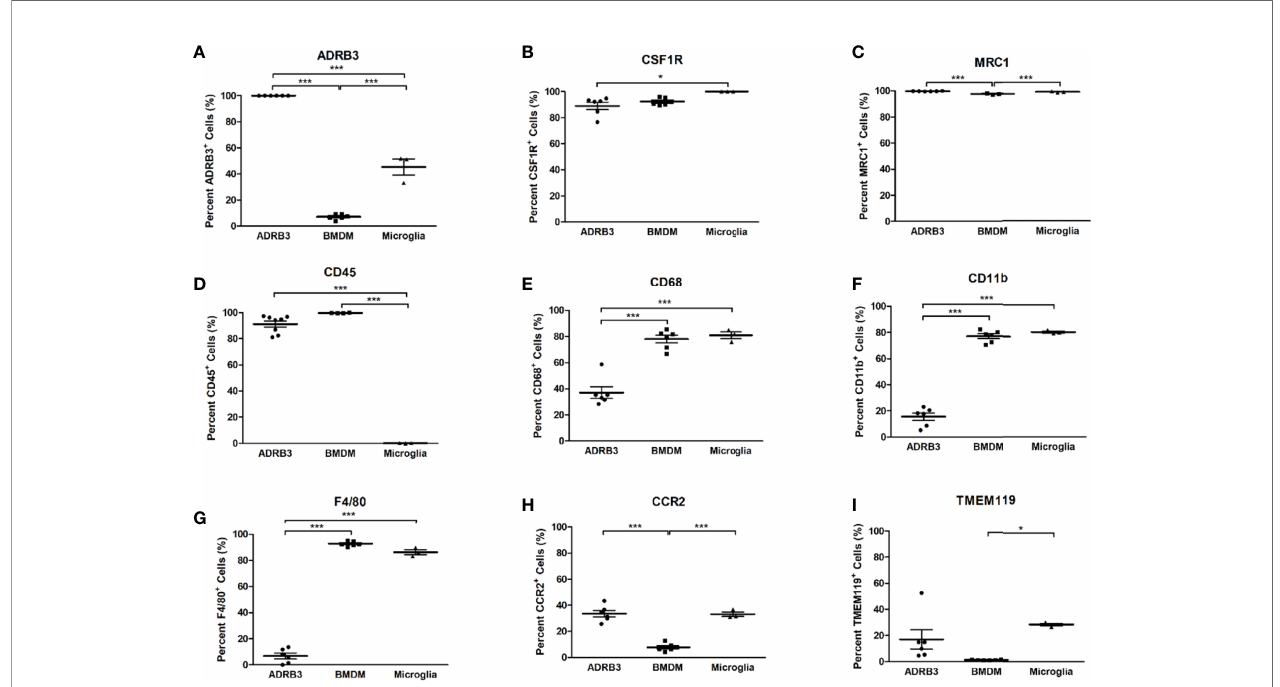
FIGURE 3 | ADR b 3+ cells express several macrophage markers, but lack expression of CD11b and F4/80. Macrophage surface markers were quanti fi ed on ADR b 3+ macrophages, bone-marrow-derived macrophages(BMDM), and microglia. Comparisons were made between these cell types to determine commonality. Signi fi cant differences (p<0.5) were calculated using an ANOVA with Tukey correction. Symbols represent sample data points, and horizontal lines depict the mean. Standard error of the mean (SEM) is shown by the capped vertical line. *p < 0.05, ***p < 0.001. Flow cytometry was used to quantitate all types of macrophages in both the Figure 3 legend as well as in the test in the Results. Adrb3+ macrophages, BMDM, and microglia were compared for percent positivity to (A) Adrb3; (B) Csf1r; (C) Mrc1; (D) Cd45; (E) Cd68; (F) Cd11b; (G) F4/80; (H) Ccr2; and (I) , Tmem119.